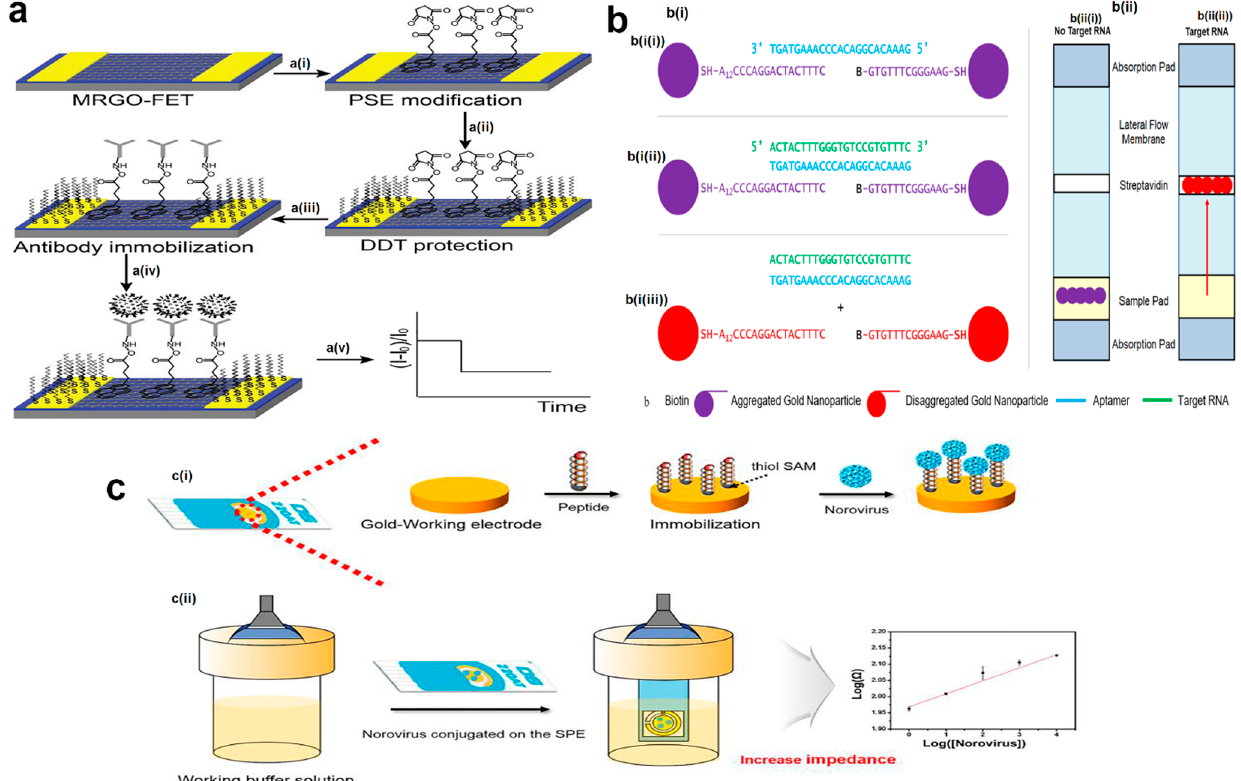
Figure 4. ( a ) Real-time detection of rotavirus antibodies using a micropatterned reduced graphene- oxide-based field-effect transistor. a ( i ) Connection of PSE on MRGO surface, a ( ii ) DDT treatment, a ( iii ) immobilization of rotavirus-specific antibodies, a ( iv ) rotavirus capture, and a ( v ) real-time monitoring of rotavirus by electrical signaling. ( b ) Schematic illustration of the gold-aptamer-nanoparticle- based biosensor with ( b ( i )) colorimetric and ( b ( ii )) lateral flow response. ( b ( i ( i ))) Nanoparticles are functionalized with Sequence A (SH-5 (cid:48) A12CCC AGG ACT AC T TTC 3 (cid:48) ) and Sequence B (bi- otin -5 (cid:48) GTG TTT CGG GAA G 3 (cid:48) -SH) then aggregate by aggregating oligonucleotide (aptamer). ( b ( i ( ii ))) Oligonucleotide hybridizes with target nucleic acid (conserved enterovirus sequence) which ( b ( i ( iii ))) makes the nanoparticles, disaggregates, and changes their colors into red. ( b ( ii ( i ))) Aggre- gated nanoparticles are not able to move up through the lateral flow membranes, while ( b ( ii ( ii ))) in disaggregated form, they flow via lateral flow and bind to streptavidin due to biotin functionalization. ( c ) Norovirus detection by use of an impedance electrochemical biosensor. ( c ( i )) Immobilization of peptide self-assembly monolayers (SAMs) on the Au-working electrode. ( c ( ii )) Affinity strength